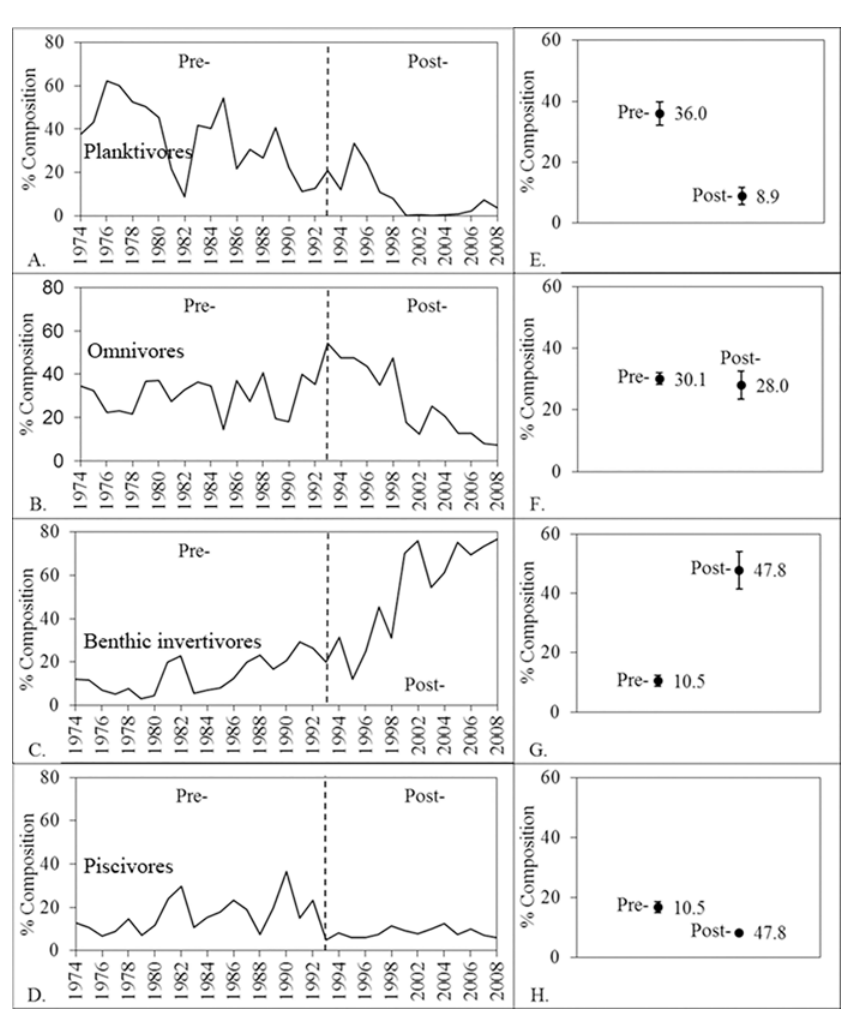
Fig 2. Mean percent composition of planktivores (A,E), omnivores (B,F), benthic invertivores (C,G), and (D,H) piscivores during time periods (1) 1974 – 1992, and (2) 1993 – 2008. Variation is indicated by standard error